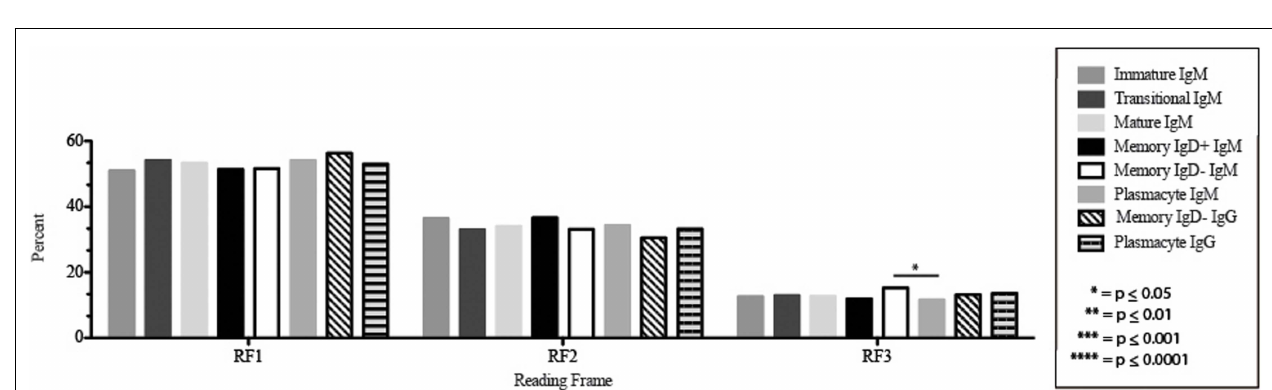
peripheral blood from immature B cells through plasmacytes are displayed. All comparisons were made using χ 2 -test or Fisher’s exact test as appropriate. Significant differences among each fraction in the different mice are indicated by asterisks: * p ≤ 0.05, ** p ≤ 0.01, *** p ≤ 0.001, **** p ≤